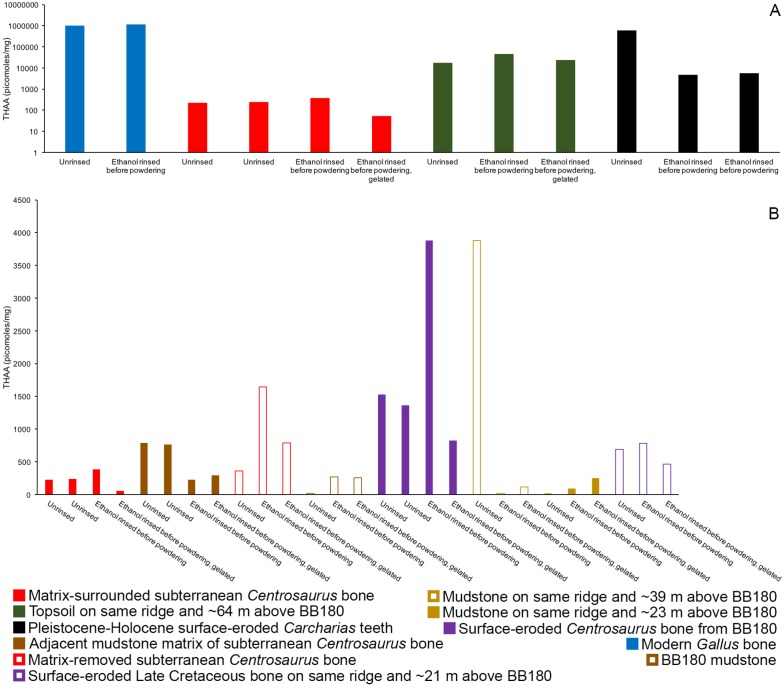
THAA concentrations (summed total of all amino acids measured) of the samples.(A) Logarithmic scale comparison of modern Gallus bone (blue), matrix-surrounded subterranean Centrosaurus bone (red), Pleistocene-Holocene surface-eroded shark teeth (black, with a repeated measurement for the ethanol rinsed sample), and topsoil on same ridge and ~64 m above BB180 (green). (B) Comparison between fossil Late Cretaceous bone and mudstone. Matrix-surrounded subterranean Centrosaurus bone (solid red), adjacent mudstone matrix of subterranean Centrosaurus bone (solid brown), uncovered subterranean Centrosaurus bone (open red), BB180 mudstone (open brown), surface-eroded Centrosaurus bone from BB180 (solid purple), mudstone on same ridge and ~39 m above BB180 (open tan), mudstone on same ridge and ~23 m above BB180 (solid tan), and surface-eroded Late Cretaceous bone on same ridge and ~21 m above BB180 (open purple). Gelated replicates likely provide the most accurate measurements given the peak reduction present in the non-gelated replicates.